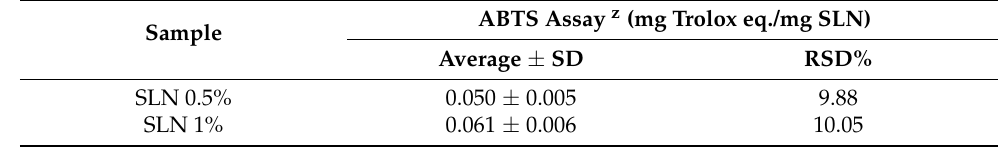
Table 8. Antioxidant capacity measured with the ABTS assay of the SLN formulations. Sample